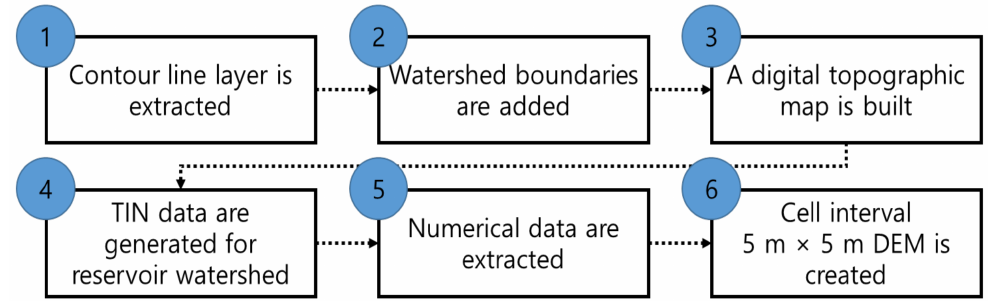
Figure 4. Reservoir modeling flow chart. To quantitatively identify the altitude and topographic characteristics of the reservoirs, procedures (1)–(6) were